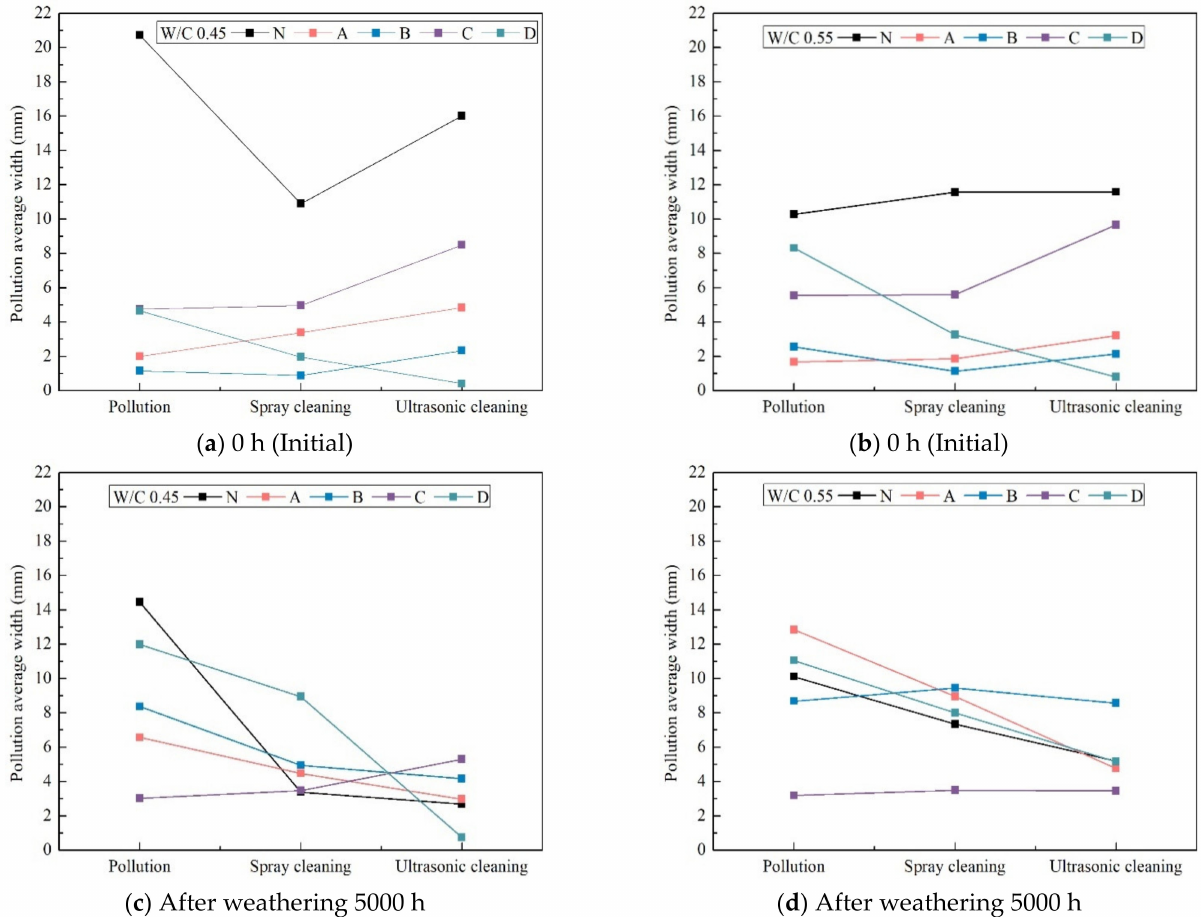
Figure 10. Pollution average width measurements of all protective coatings at different times of xenon-arc light exposure after pollution and cleaning (spray and ultrasonic